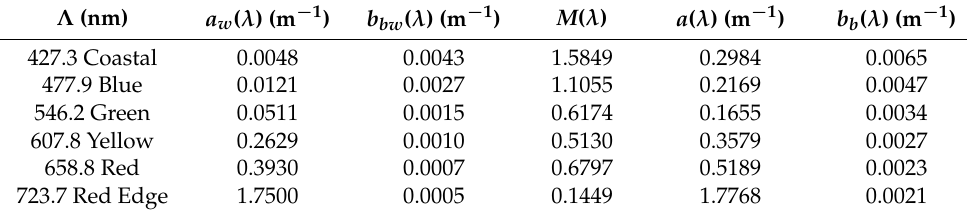
Table 2. Coefficients for water column correction ( a w ( λ ) and b bw ( λ ) are pure-water absorption and backscattering coefficients. M ( λ ) is the coefficient defined by Austin and Petzold. a ( λ ) is the total absorption coefficient. b b ( λ ) is the backscattering